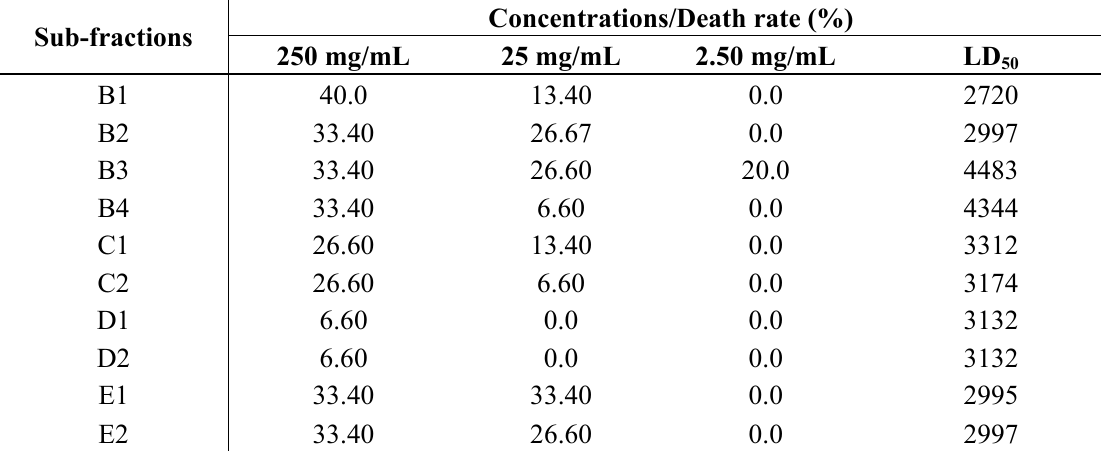
Table 5. Lethality of T. indica sub-fractions on chicken embryo.